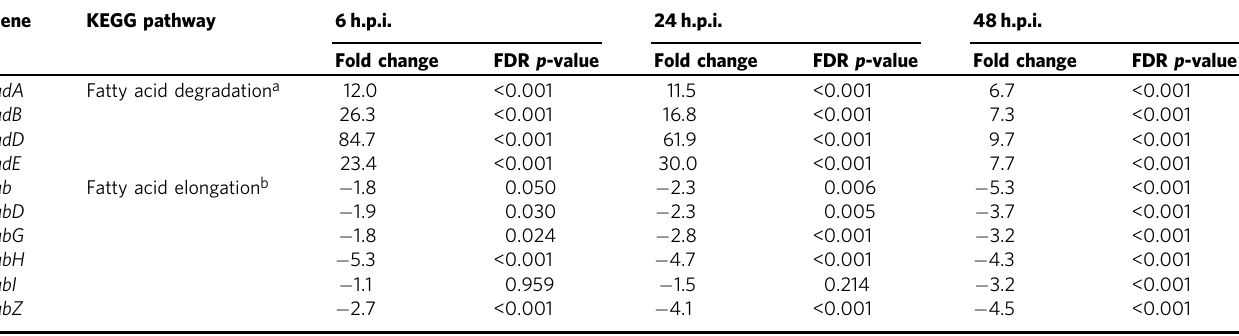
Table 2 Gene expression change of S. aureus lipid metabolism in the host liver compared with culture medium. Gene KEGG pathway 6